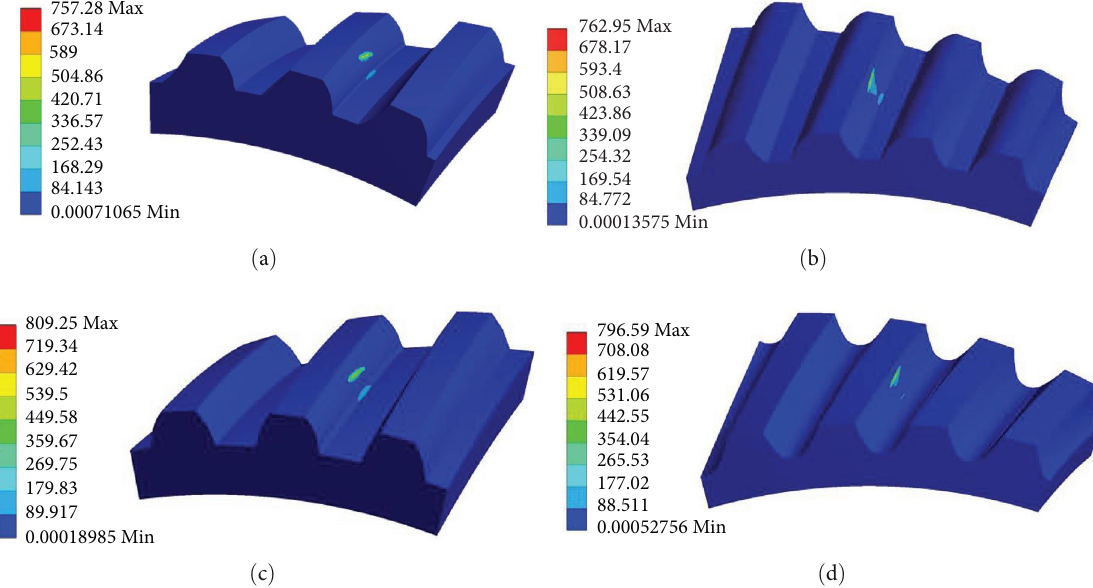
F IGURE 20: Contact stress: (a) and (b) are the driving and driven gears of the asymmetric logarithmic spiral gear, respectively; (c) and (d) are the driving and driven gears of the pure rolling single arc gear, respectively.